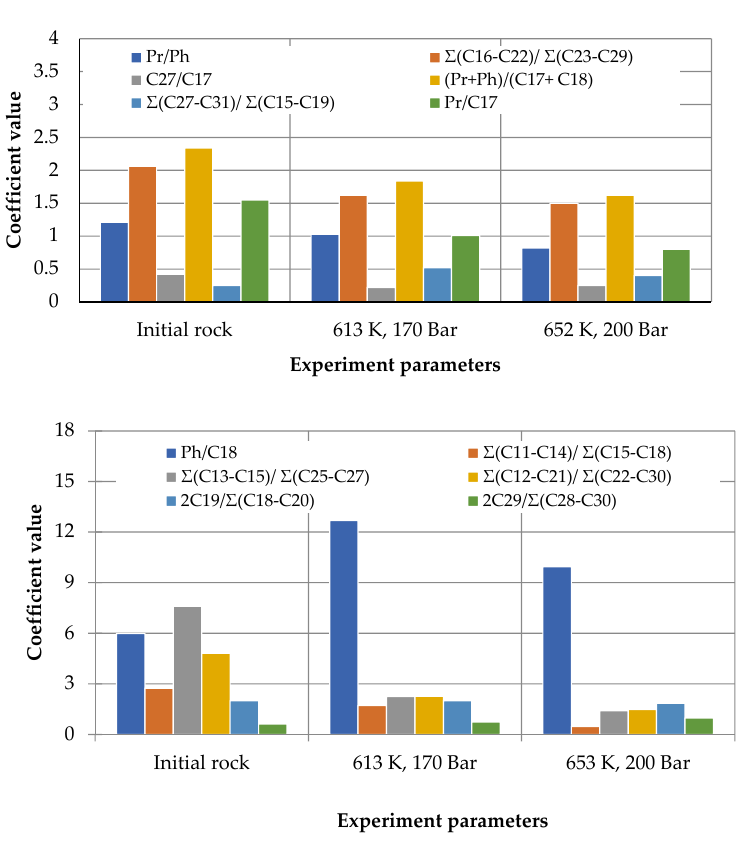
Figure 4. Geochemical coefficients of saturated hydrocarbons in extracts from carbonate rocks before and after experiments.